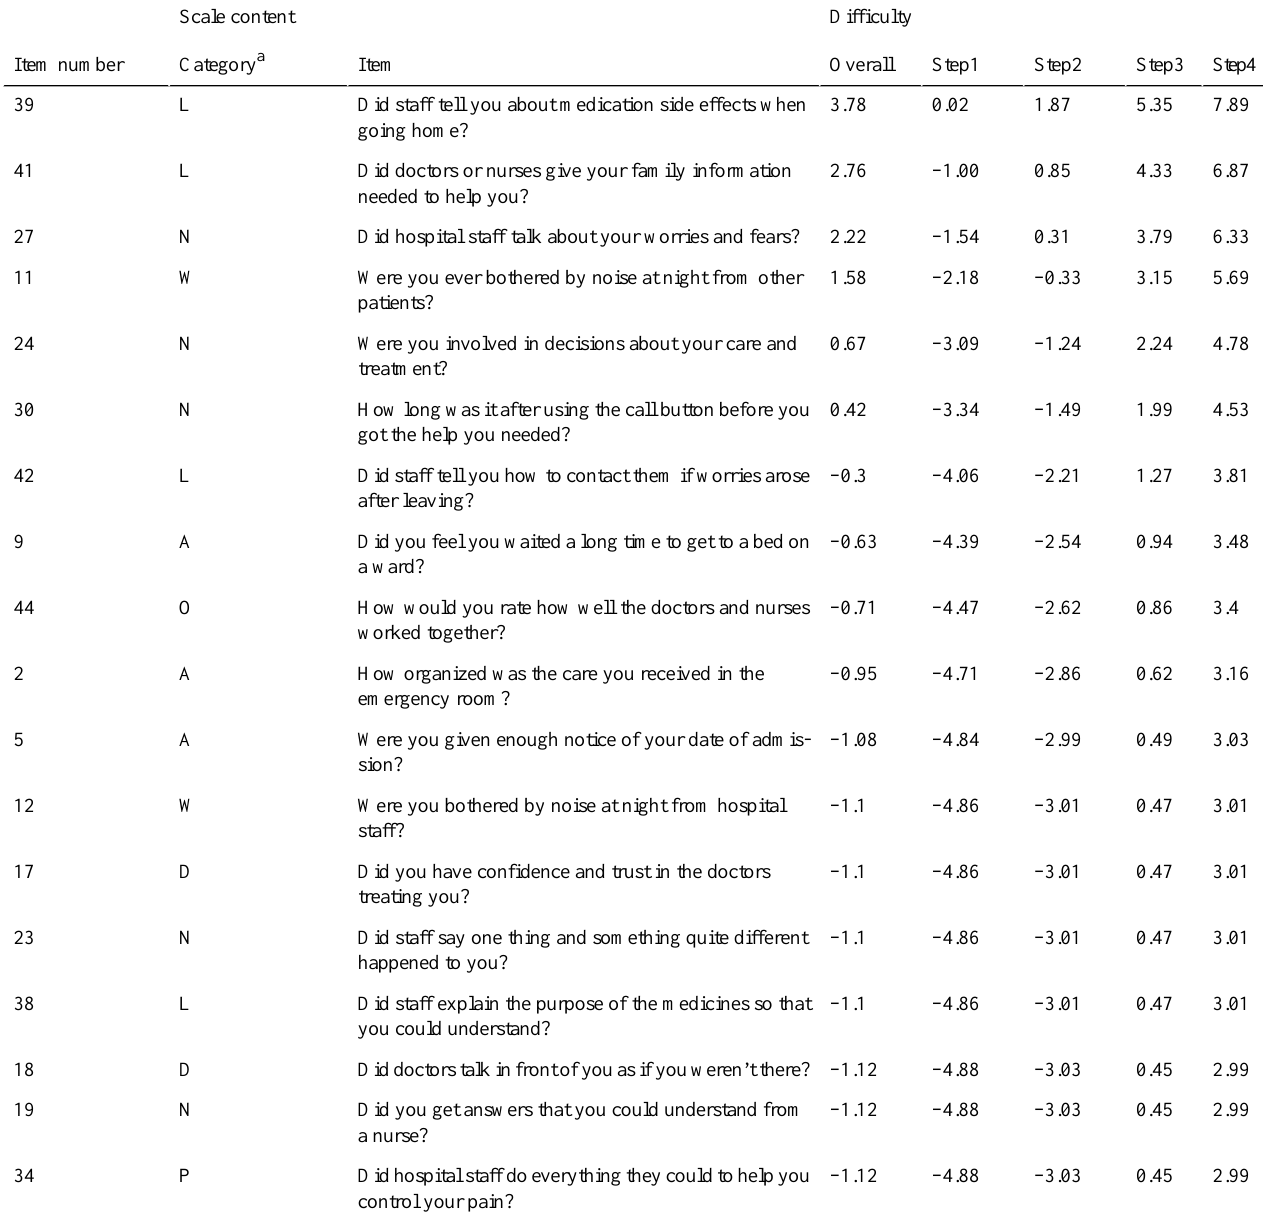
Table 1. Items of the 18-item scale ordered by item overall